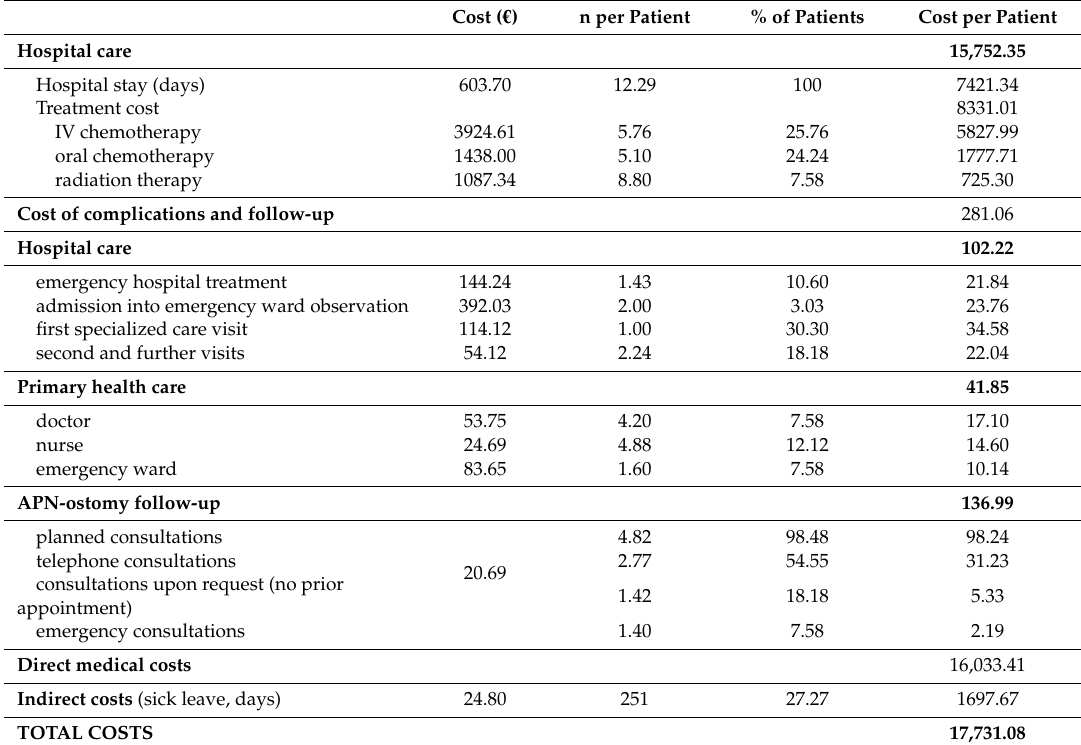
Table 5. Costs of an ostomized